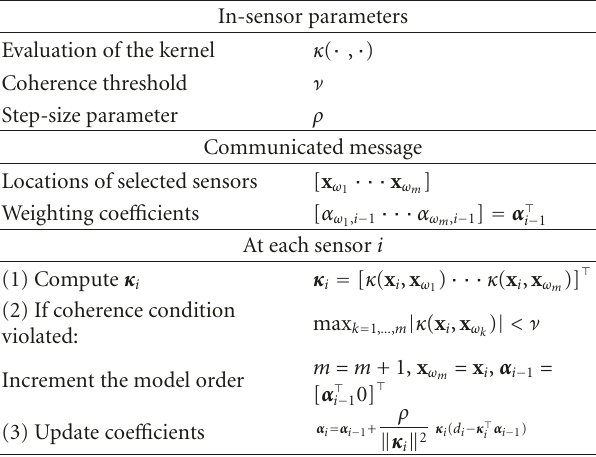
Table 1: Distributed learning